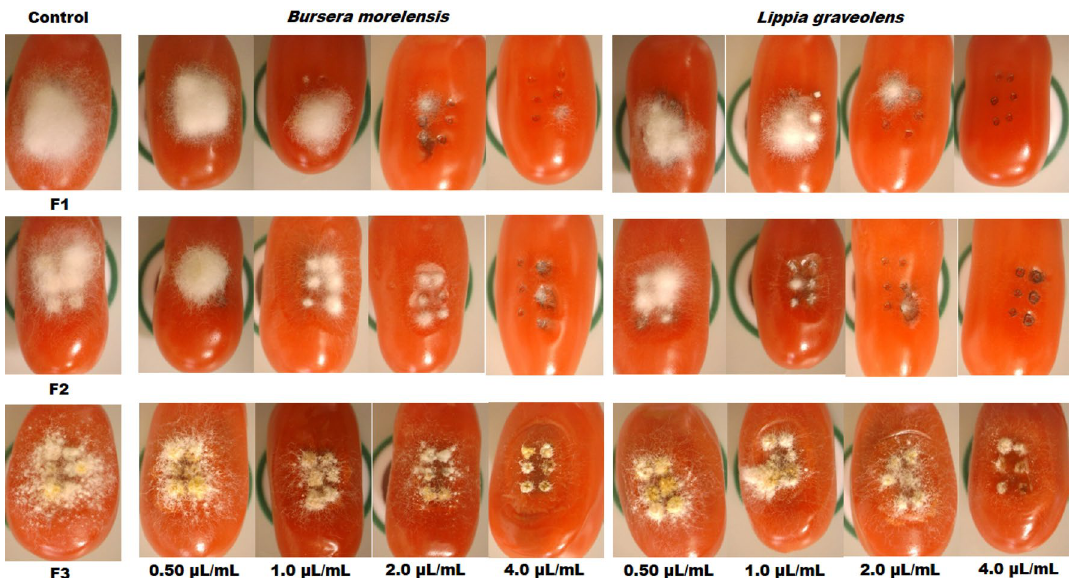
Figure 4. Effect of essential oils on the growth of three Fusarium strains in a plant model. Inhibition of Fusarium sporotrichioides (F1), Fusarium moniliforme (F2), and Fusarium solani (F3) growing on cherry tomatoes exposed to Bursera morelensis and Lippia graveolens essential oils at concentrations of 0.5, 1.0, 2.0, and 4.0